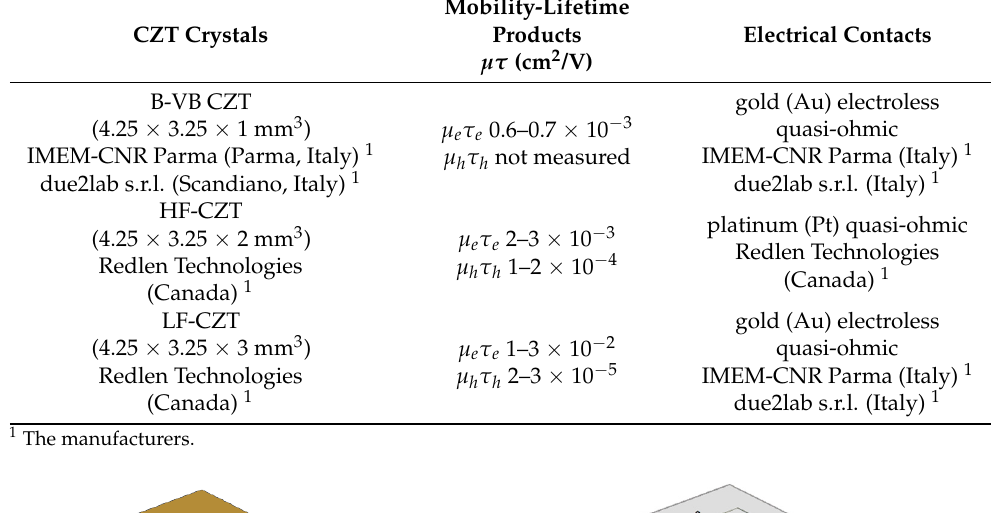
Table 1. The key characteristics of the CZT pixel detectors.